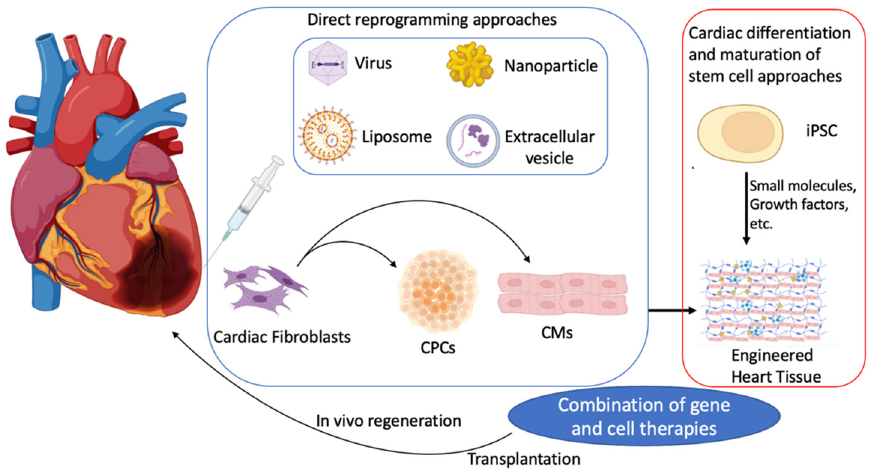
Figure 1. Recent advanced methodologies for regenerative heart disease treatment. hiPSCs differentiate and maturate into hiPSC-CMs for transplantation and further functionalize for engineered heart tissue process (right side). Current genetic direct reprogramming techniques, in vitro and in situ, for cardiac fibroblast cells reprogramming into induced cardiomyocytes (iCMs), and induced cardiac progenitor cells (iCPCs) through transcriptional factors by viruses, microRNAs, and small